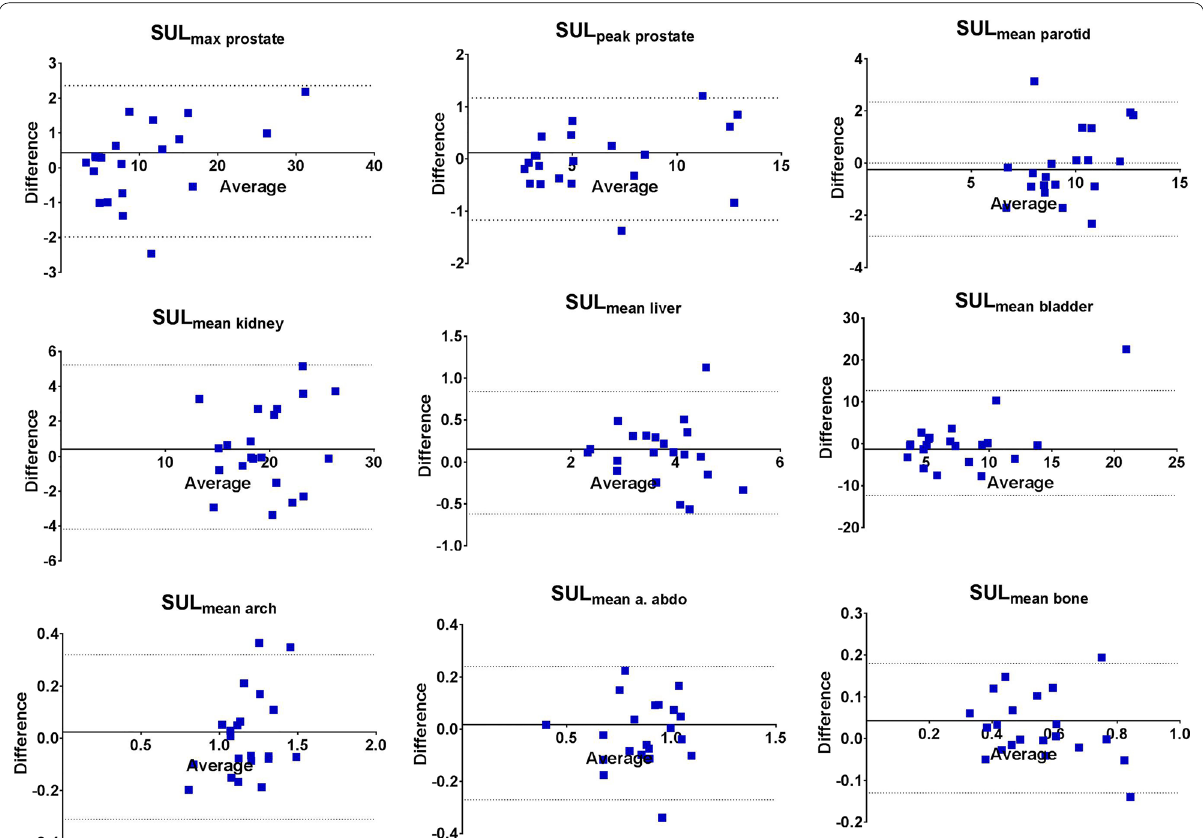
Fig. 3 Bland–Altman plots of the absolute difference in SUL max , peak of the prostate tumor, and SULmean of the parotid, liver, bladder, kidney, blood pool (abdominal aorta and ascending aorta), and bone. Horizontal lines represent the mean differences and the 95% confidence intervals of limits of